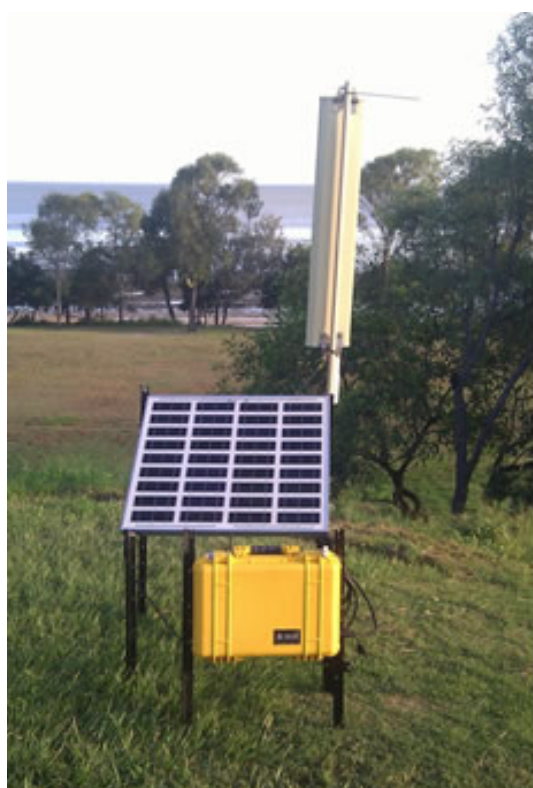
Figure 9. The SEMAT Mk2 base station on Sandstone Point at Deception